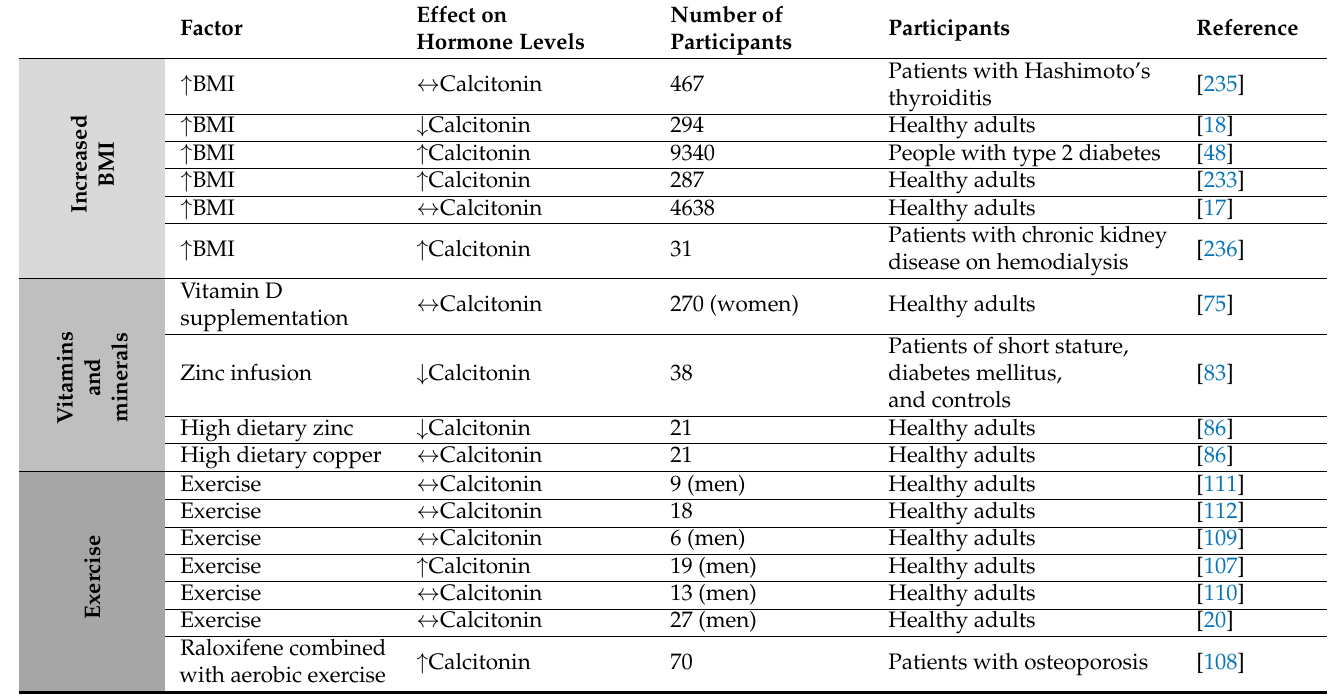
(Table 3). Exposure to persistent organochlorine compounds (p,p (cid:48) -diphenyldichloroethene (p,p (cid:48) -DDE) and polychlorinated biphenyls (PCBs)) did not affect PTH levels